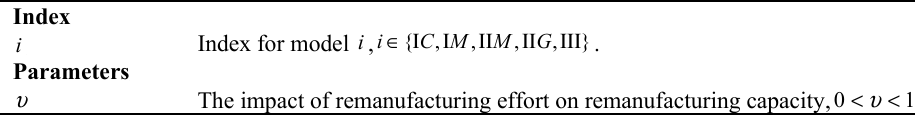
Index, parameters, variables and